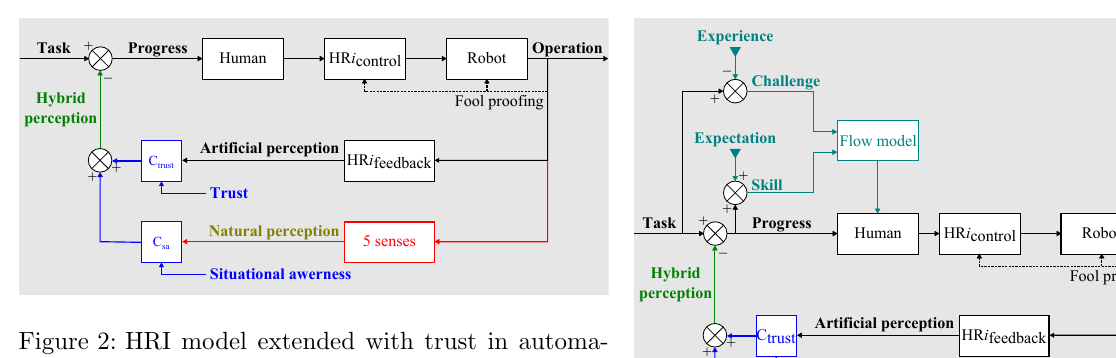
Figure 2: HRI model extended with trust in automa- tion and situational awareness